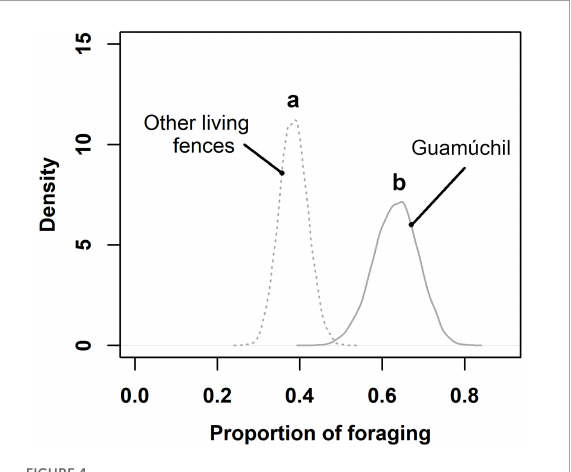
FIGURE4 Estimated proportion of bird foraging for different types of live fences in Zacualpan, Colima, Mexico. Letters above curves depict statistical differences among estimations. Other live fences included both shrubs and non-Guamúchil